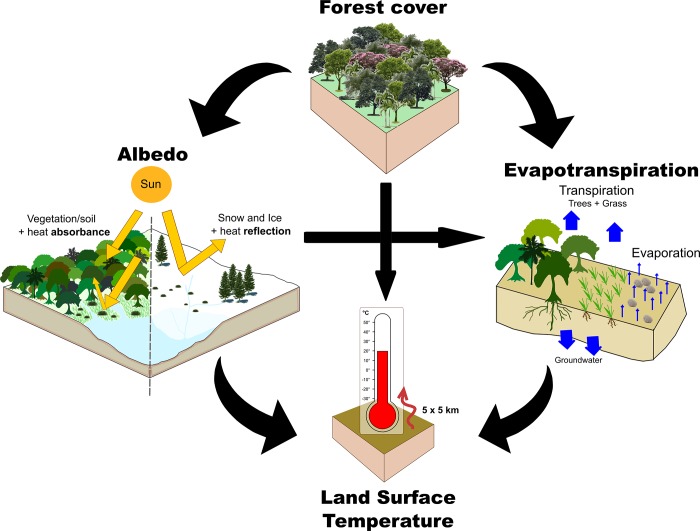
Scheme depicting presumed relationships between forest cover and climatic variables (albedo and evapotranspiration).These climatic variables are regarded as the main drivers of land surface temperature change. Heat is more readily absorbed by vegetation, soil and water bodies (lower albedo values), than surfaces with snow and ice (higher albedo values). By estimating condensed water from substrate evaporation and vegetation transpiration, we quantify the available water in the air (evapotranspiration). At the same time, heat absorbance induces greater water condensation by both soil and vegetation.